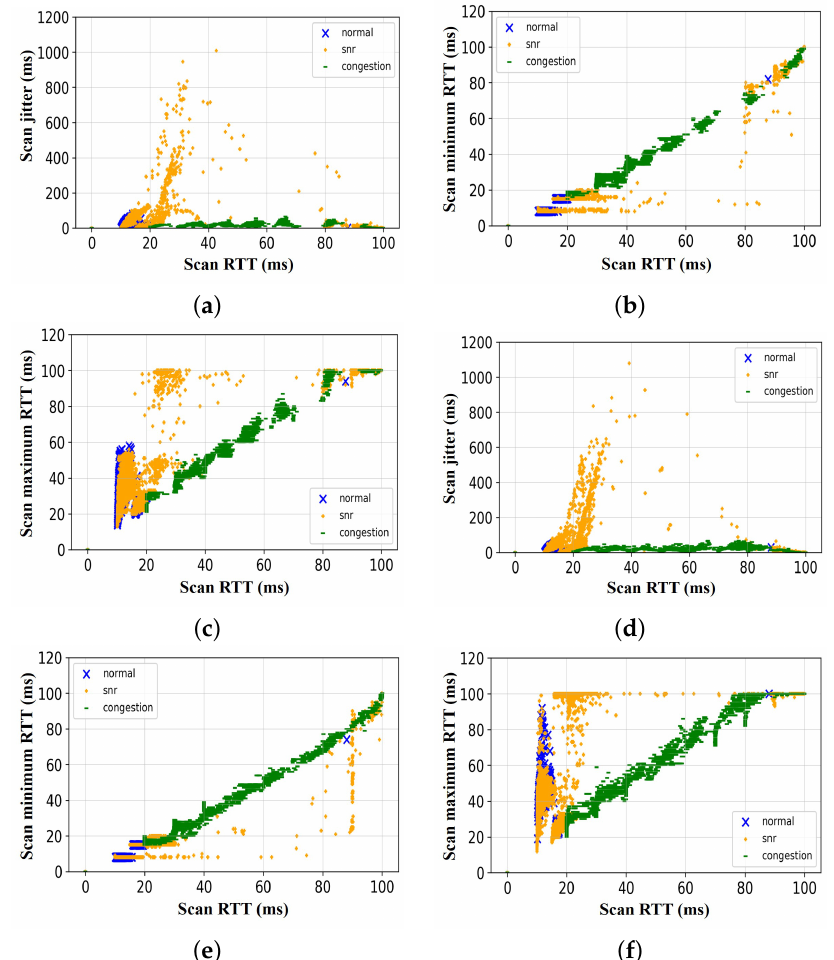
Figure 8. Relationship of other features of the scan traffic to scan response RTT in all scenarios. Set 1: ( a ) Scan RTT vs. scan jitter; ( b ) scan RTT vs. scan minimum RTT; ( c ) scan RTT vs. scan maximum RTT. Set 2: ( d ) Scan RTT vs. scan jitter; ( e ) scan RTT vs. scan minimum RTT; ( f ) scan RTT vs. scan maximum